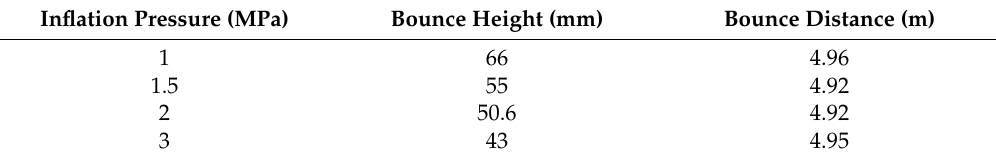
Table 6. Test result of bounce height and bounce distance with di ff erent inflation